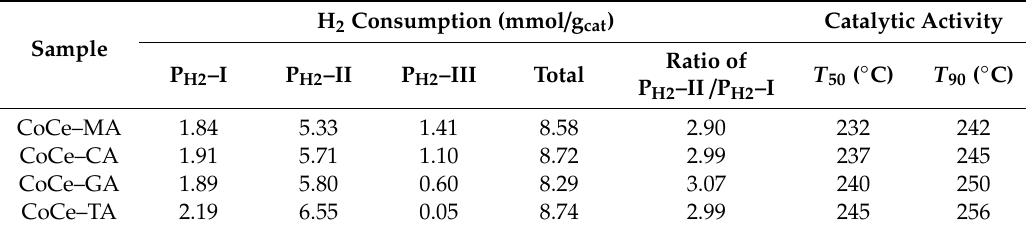
Table 5. H 2 consumption and catalytic activities of the CoCe–X catalysts.